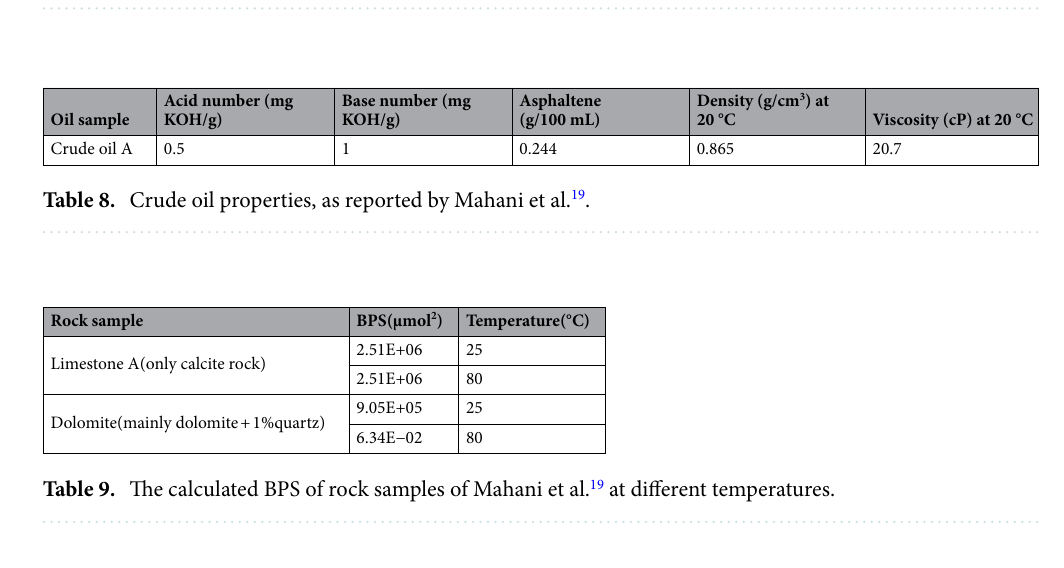
Table 7. Ionic composition of injected brine, as reported by Mahani et al. 19 .